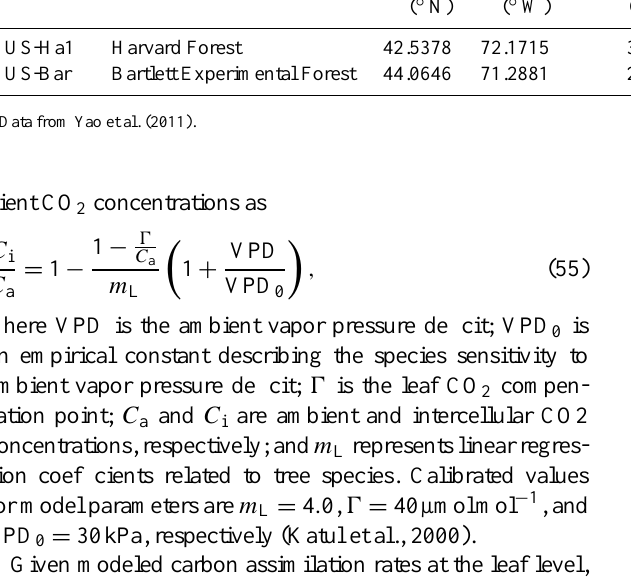
Table 1. Site information as obtained from the AmeriFlux website unless notified. Site